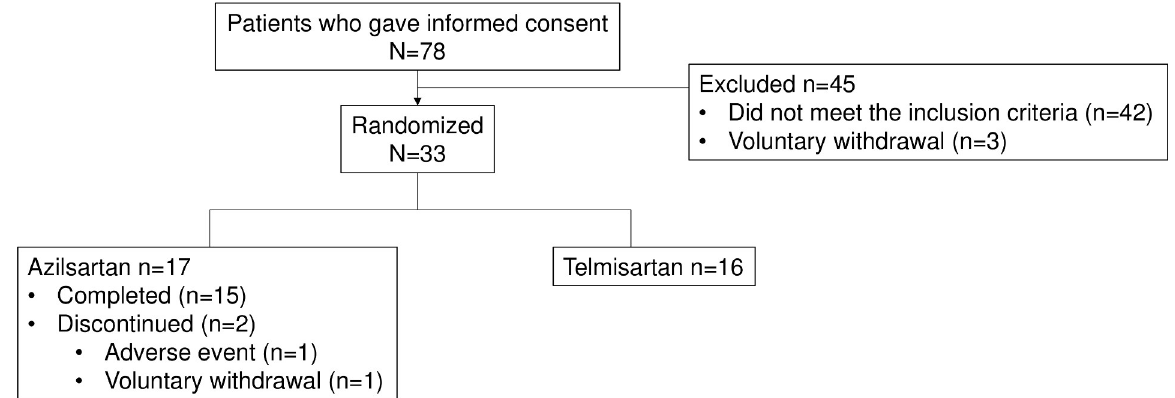
Fig 1. CONSORT diagram of participant